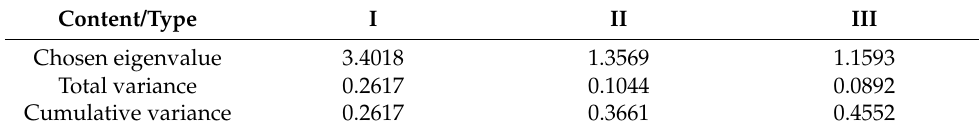
Table 3. Eigenvalues and explanatory variances in the classification of the three types.